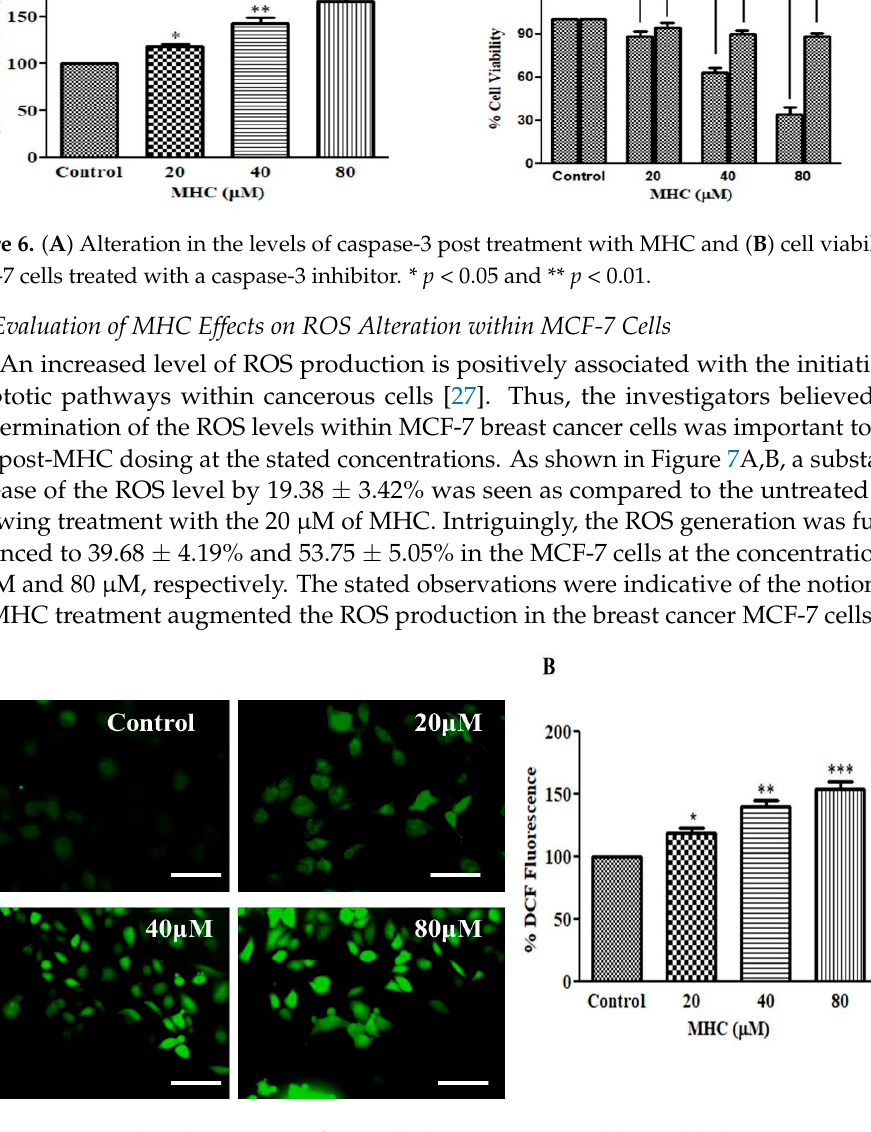
Figure 8. Alterations in the levels of NF- κ B post-exposure with MHC . ** p < 0.01 and *** p < 0.001 3. Discussion The constitutive activation and/or expression of the NF- к B pathway is responsible for positively regulating cell proliferation, and tumor growth with a concomitant sup- pression of apoptotic cell death during breast cancer [27]. Elevated NF- к B DNA-binding activity has been established in pre-clinical breast cancer models. Intriguingly, p50/RelA heterodimer was documented to be related in nearly 86% of estrogen receptor (ER)-negative and Her2/ErbB2-positive breast tumors [28]. Indeed, it has been previously reported that an activation of NF- κ B is induced by Her2/ErbB2 via modulation of the PI3K/Akt pathway where the degradation of I к B α is achieved through calpain [29]. In fact, ERs have been previously reported for negatively regulating NF- к B through dif- ferent mechanisms [30]. Bioactive constituents obtained from natural resources have shown their relevance for being potent anti-cancer therapeutics. Among these bioactive constituents, the deriv- atives of carbazole alkaloid hold the potential for compromising DNA integrity within cells by inhibiting the functioning of the DNA replication enzymes, which in turn re- stricts the functioning of different kinases and acts as an antagonist for estrogen recep-